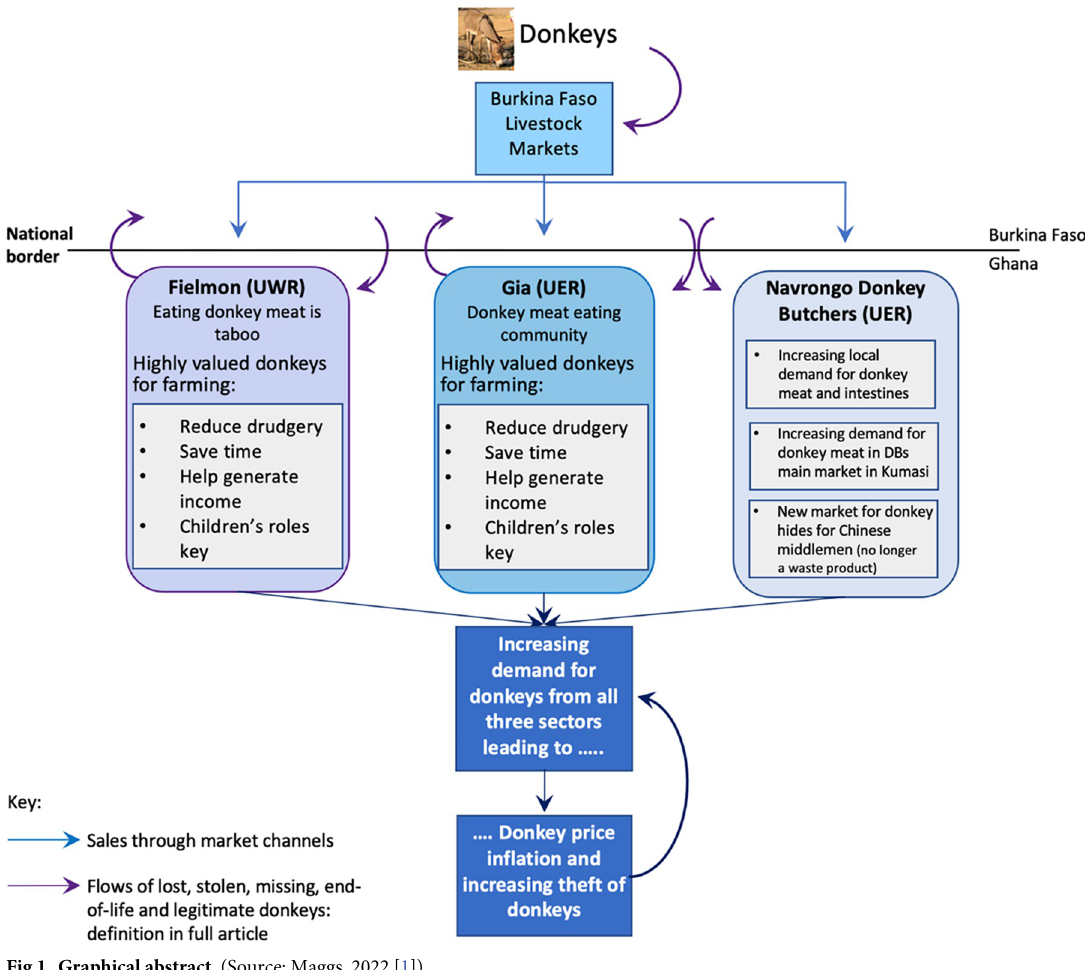
Fig 1. Graphical abstract. (Source: Maggs, 2022